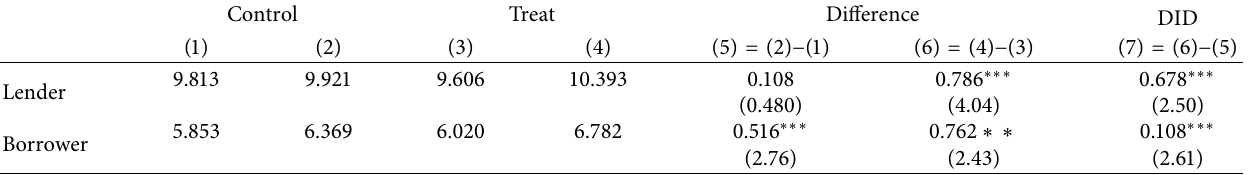
Table 11: The difference of participants between experimental group and control group under coupon strategy.